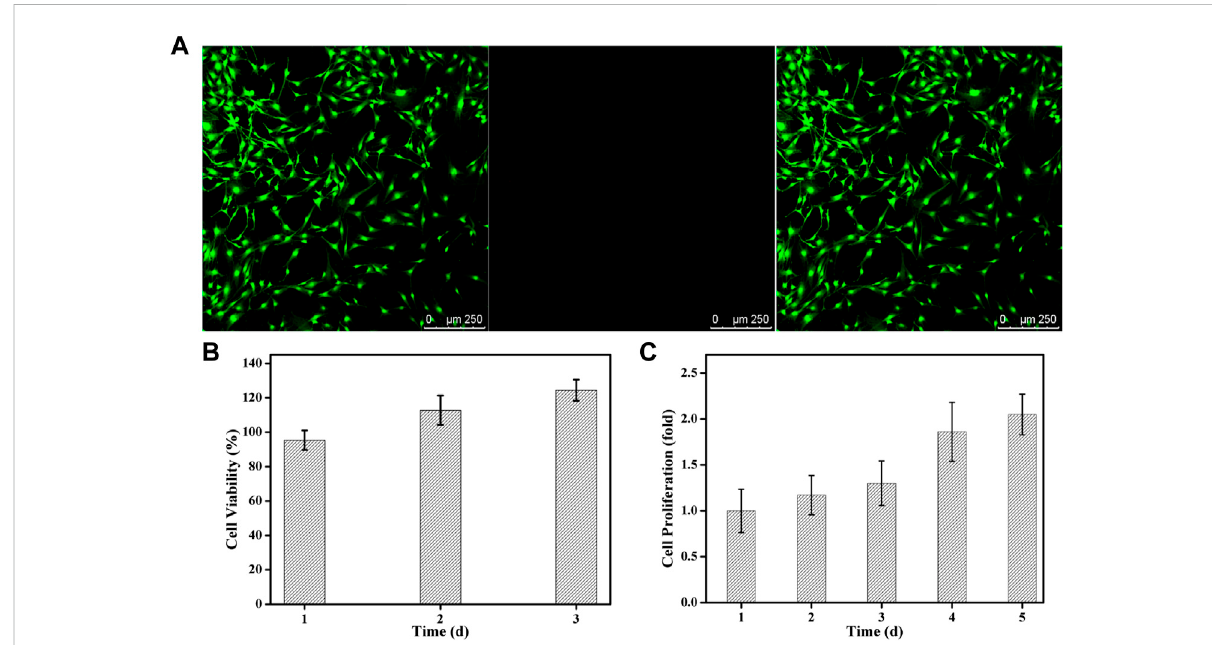
FIGURE 5 CytotoxicityofALN-conjoinedtetra-PEGhydrogel invitro . (A) Live/deadstainingofPDLSCs. Cellsingreenmanifest livingPDLSCs while cellsin red manifest dead ones. (B) Cell viability and (C) Cell proliferation was detected after cultivation for various